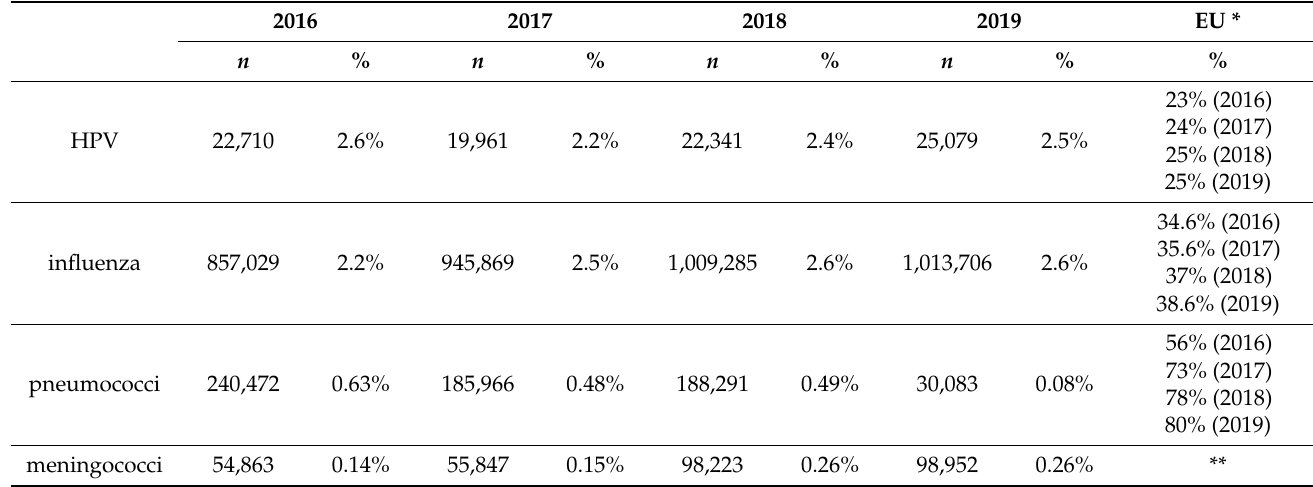
Table 2. People vaccinated in Poland and the EU between 2016 and